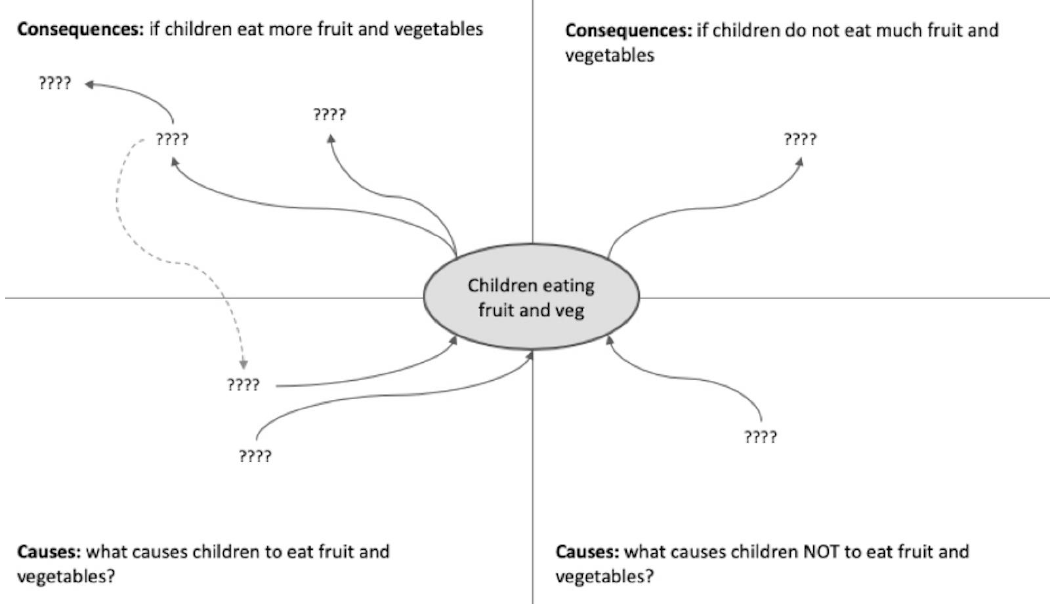
Figure 2. Causes and consequences template for cognitive mapping.